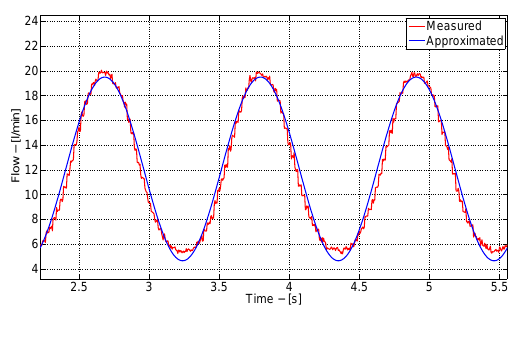
Figure 5: Illustration of the approximated flow ˆ Q .